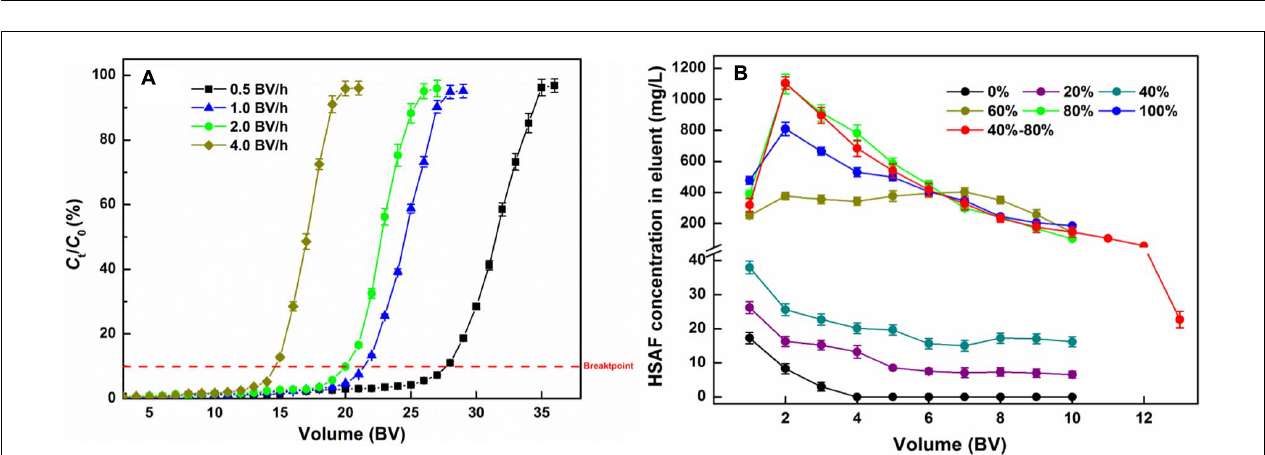
FIGURE 5 | Dynamic adsorption breakthrough curve (A) and desorption curve (B) of HSAF on the NKA packed column.